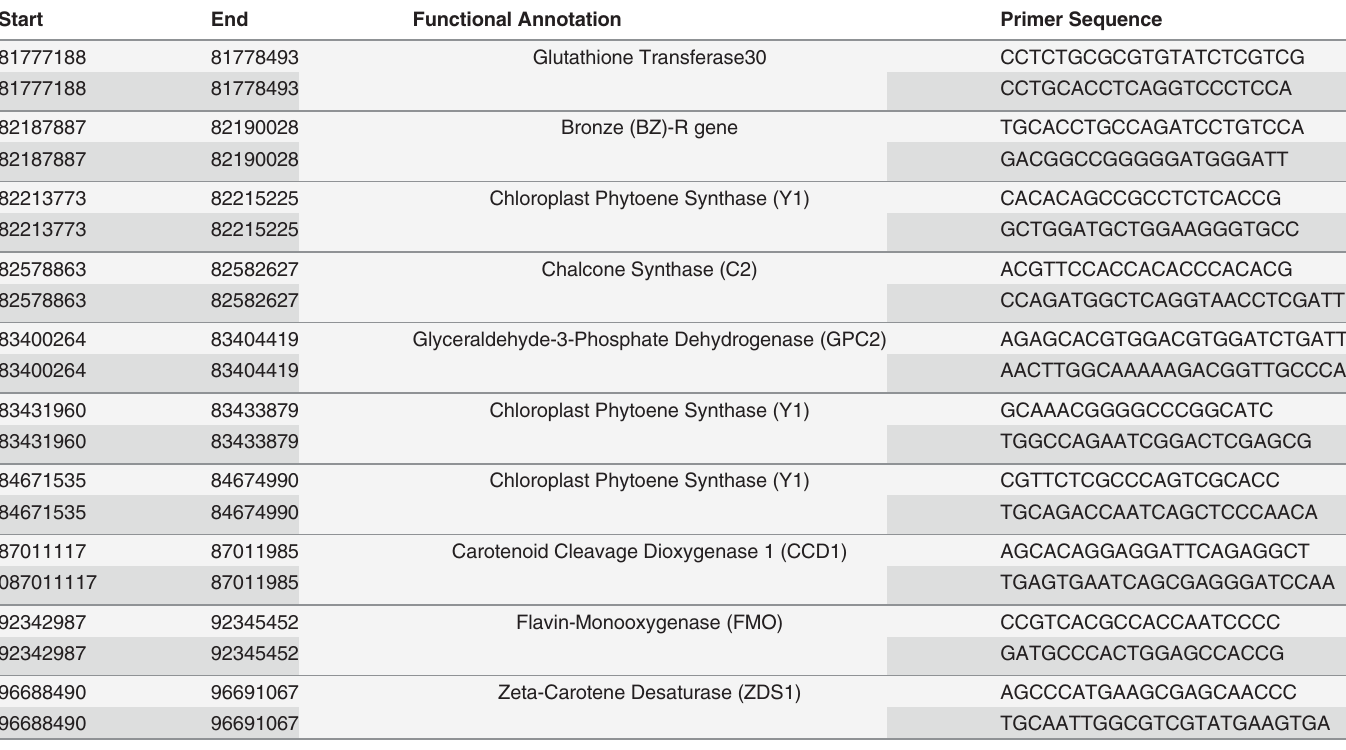
Table 7. Primer sequences used for qGLS1.04 CML228 expression